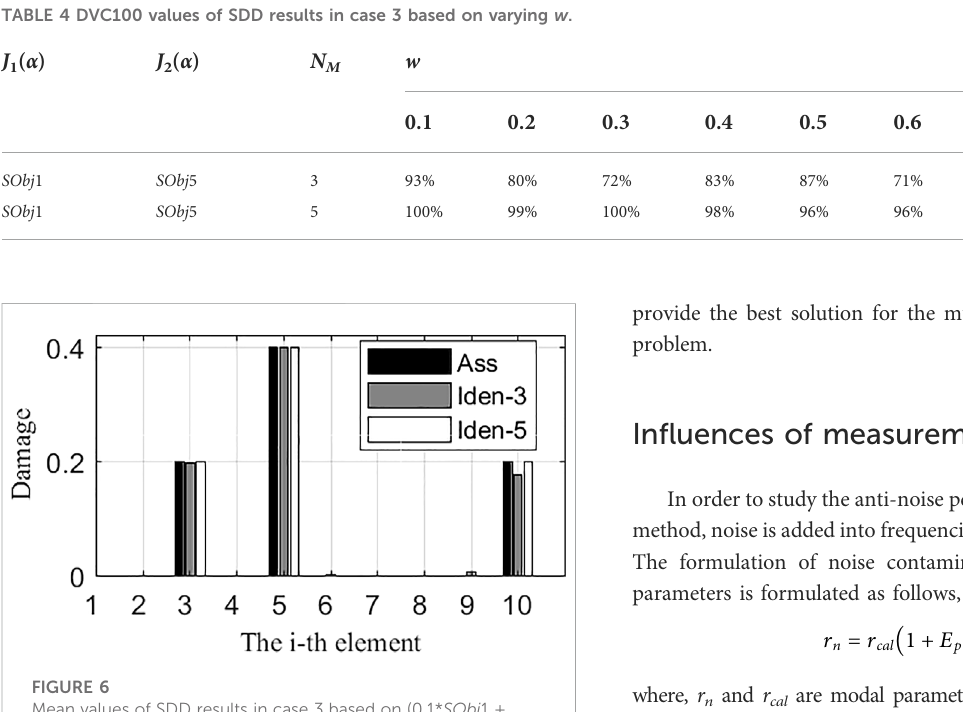
TABLE 4 DVC100 values of SDD results in case 3 based on varying w .